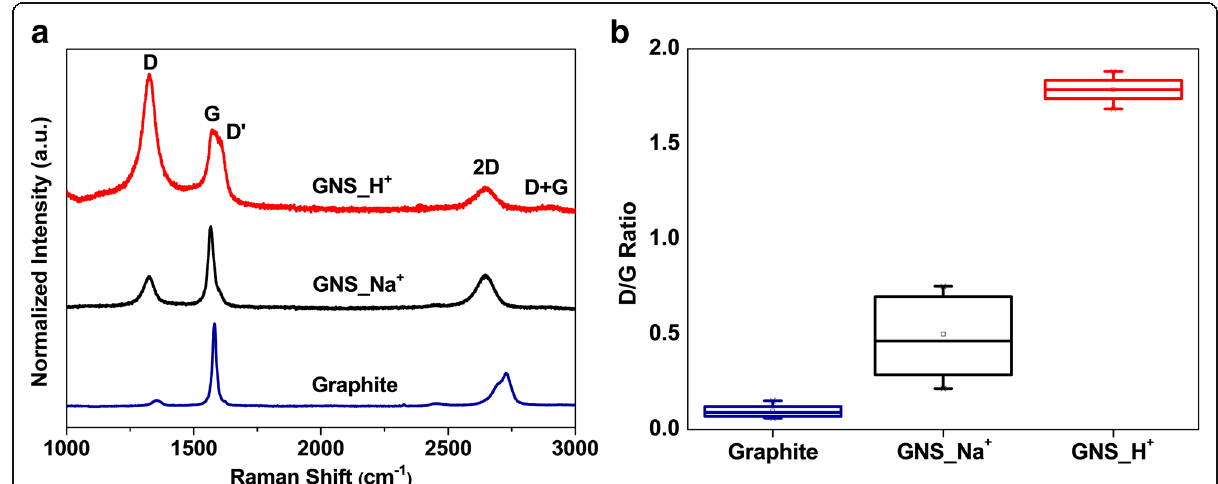
Fig. 4 a Raman spectra and b box charts of the intensity ratios of the D- and G-bands of graphite, GNS_Na + , and GNS_H